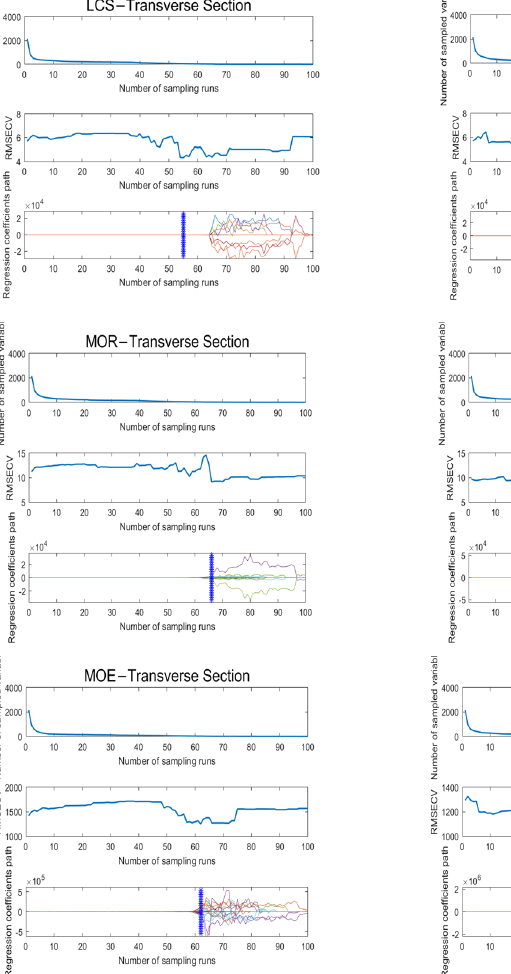
11 of 18 Figure 6. Wavelength extraction results of wood mechanical properties VIS ‐ NIRS based on SPA. CARS optimized the band of the near ‐ infrared spectrum of wood mechanical prop ‐ erties, and the results are shown in Figure 7. The optimal sampling times of wood me ‐ chanics were all less than 70 times. When the sampling times increase from 0 to 70, RMSECV fluctuates with the increase of sampling times, but the overall trend shows a downward trend. CARS selected characteristic variables to build the PLSR model, and the results are shown in Table 3. The performance of the CARS ‐ PLS model in different sec ‐ tions of LCS was better than that of the full ‐ band model. The transverse section CARS ‐ PLS model was the best; the optimal sampling times were 55 and 48, and the characteristic variables of calibration set and validation set were 48 and 78, R 2 was 0.9149 and 0.9805, and RMSE was 1.6866 and 0.6599, respectively. The accuracy of the transverse section CARS ‐ PLS model of MOR was lower than that of the full ‐ band spectral model, and the